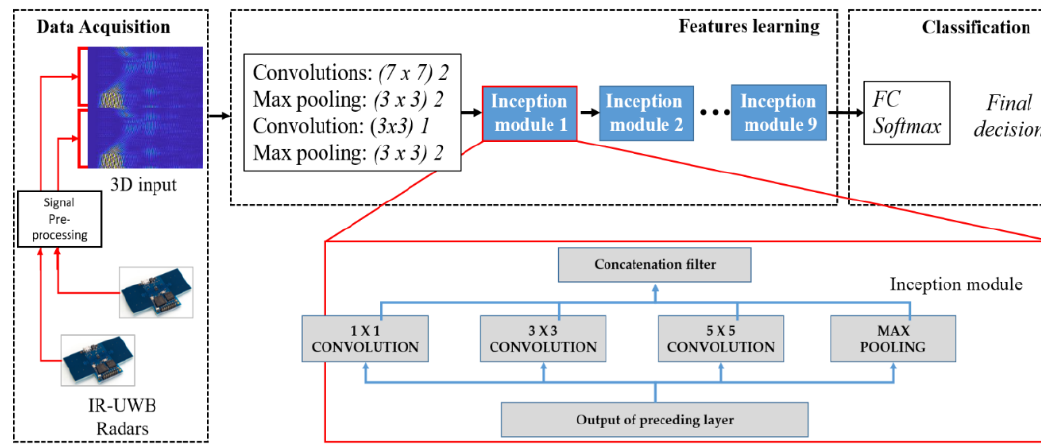
Figure 8. Structure of the proposed classifier, including a data acquisition block, feature extraction block comprising seven inception modules, and classification block.